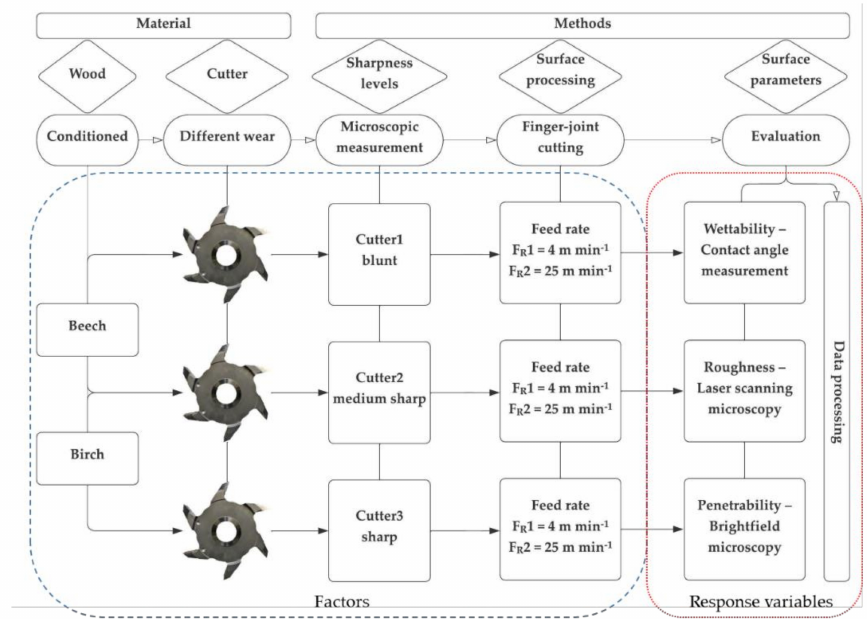
Figure 1. Overview chart of the material and methods in chronological order, the factors and the response variables of this study are